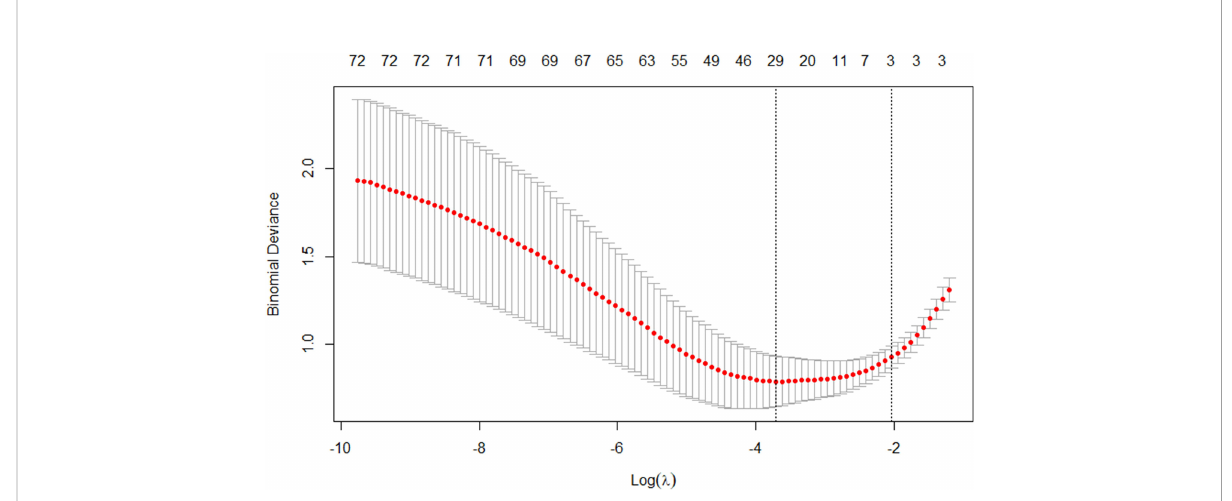
FIGURE 4 The tuning parameter in the LASSO model was chosen using a 10-fold cross-validation method based on minimum criterion. The LASSO regression cross-validation model ’ s binomial deviances as a function of logs( l ) were